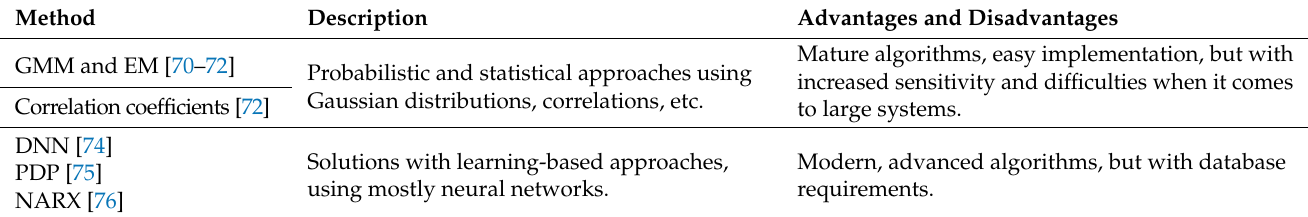
Table 3. Auxiliary algorithms for the acquisition of pseudo-measurements